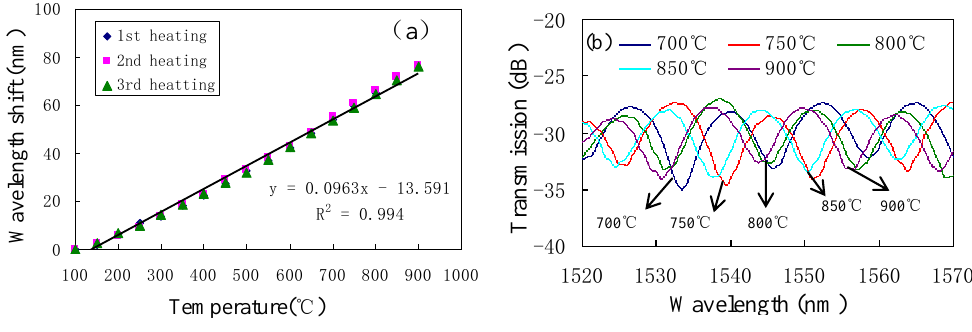
Figure 16. Interference fringes of the peanut-shape based MI with L = 22 mm at different temperatures: ( a ) temperature sensitivity; ( b ) transmission